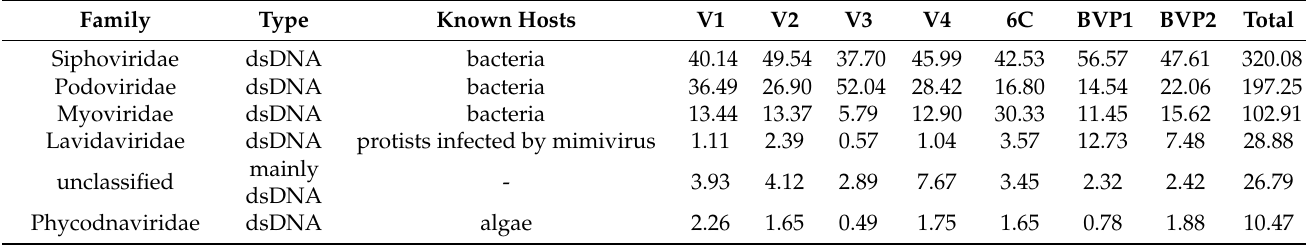
Table 4. The viral families identified in the studied and published viromes [27,28] from Lake